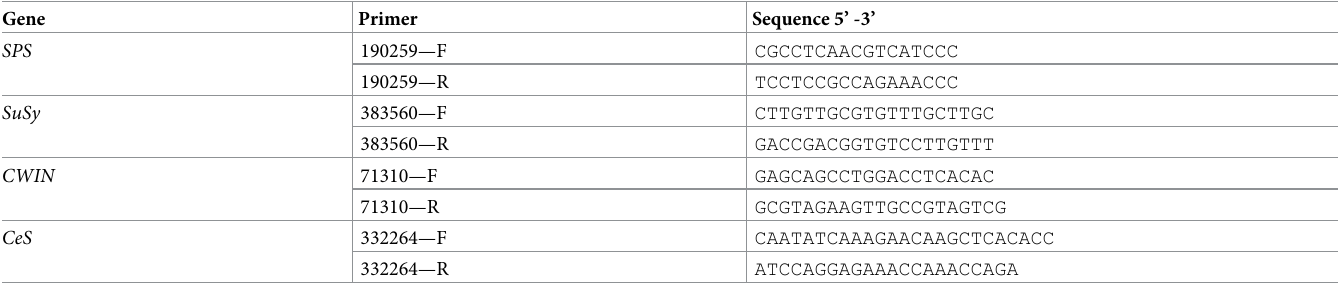
Table 1. Primers sequences used for qRT-PCR